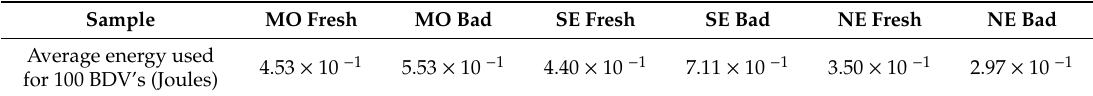
Table 3. Details of energy for 100 BDV’s.